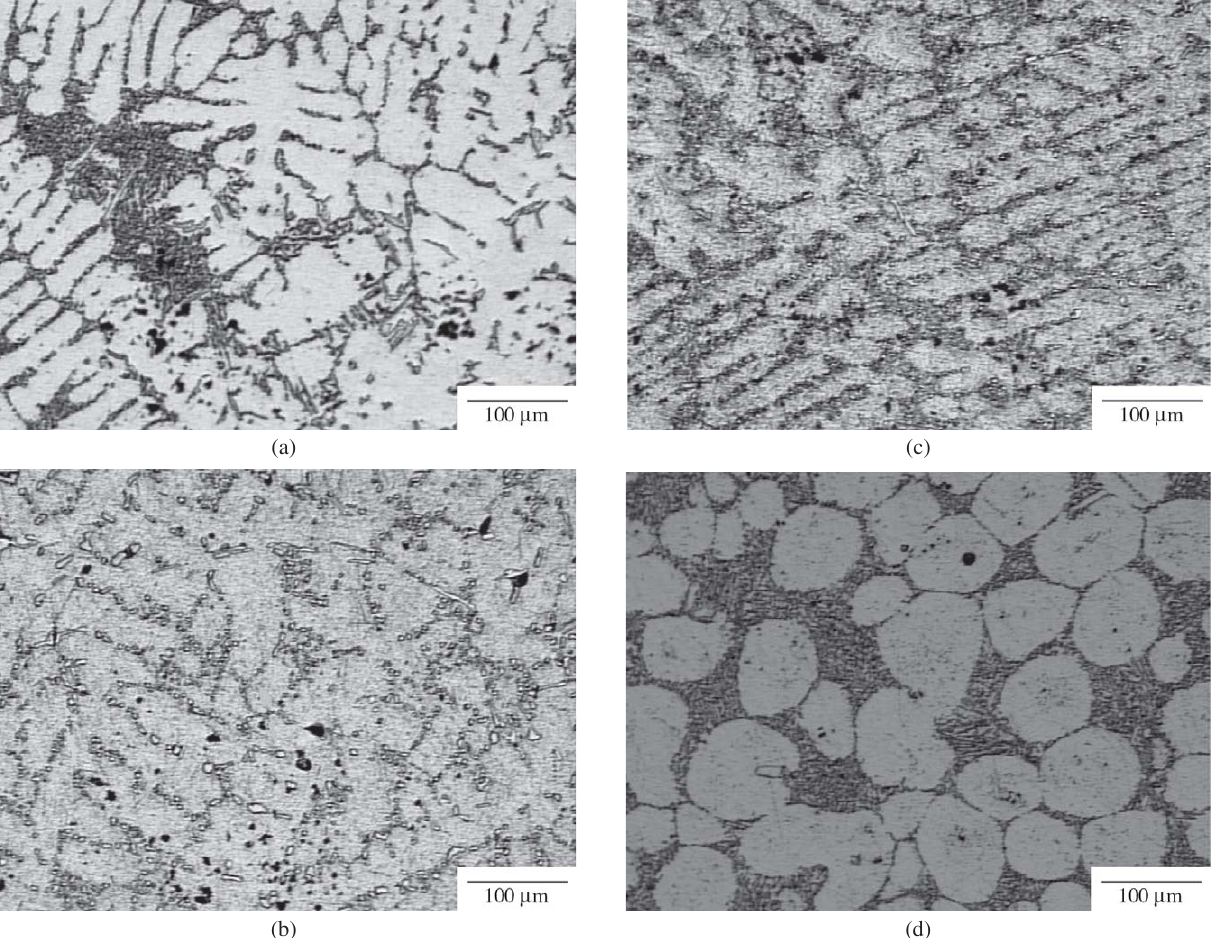
Figure 4. Microstructures of the A356 alloy: a) modified alloy; b) after homogenisation at 540 °C / 24 h; c) after plastic deformation by warm rolling (~ 300 °C) to 30% thickness reduction; d) after partial re-melting (580 °C, corresponding to f s = 0.5) and